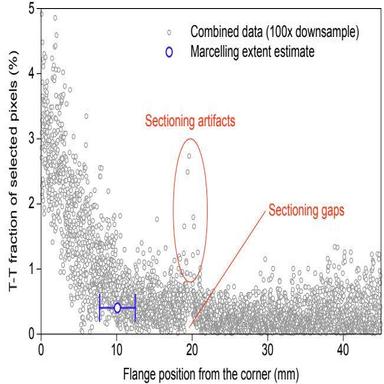
Estimation of the extent of in-plane fibre marcelling into flanges obtained from corner-flange micrographs.